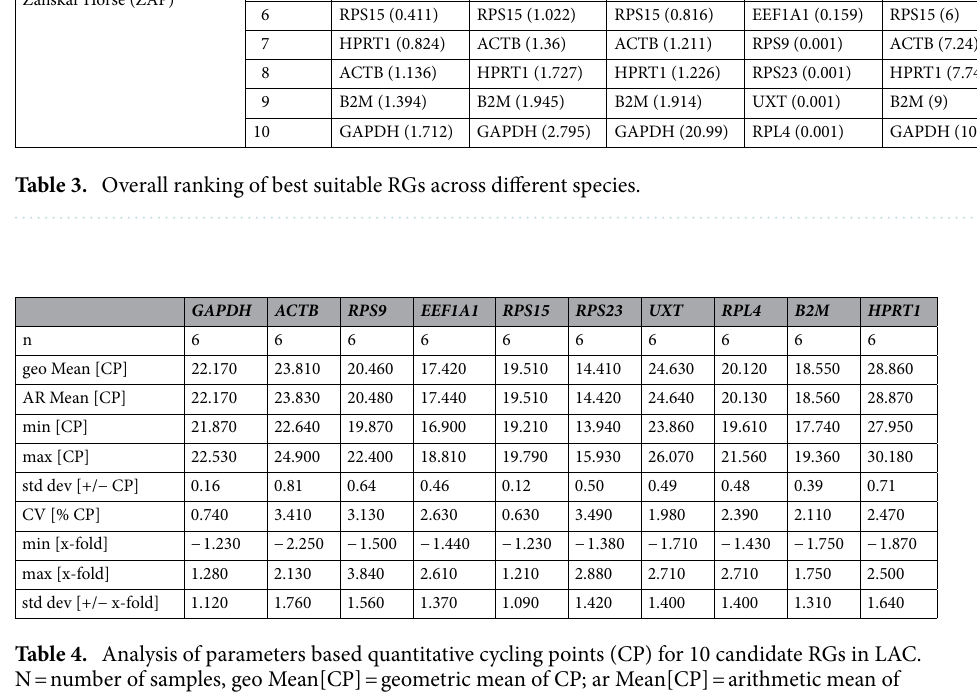
stable. This was followed by EEF1A1, ACTB and RPS23 genes with SD values of 0.294, 0.377, and 0.462, respec- tively (Table12). On the other hand, RPS15, RPL4 and GAPDH RGs with high crossing point SD values of 1.61, 1.54, 0.86 respectively were found to be least stable. Strong correlation was observed in inter gene relationship of the RGs RPL4/UXT (r = 0.908), HPRT1/UXT (r = 0.884) and HPRT1/B2M (r = 0.755) (Table 13). The relation- ship between RGs and BestKeeper was described in terms of Pearson correlation coefficient (r), coefficient of determination correlation between BestKeeper and RGs was observed for HPRT1 (r = 0.797) and B2M (r = 0.809) followed by UXT , RPS9 and ACTB gene. RefFinder based overall analysis resulted in stability ranking of RGs as; HPRT1 (1.32) > ACTB (2.63) > B2M